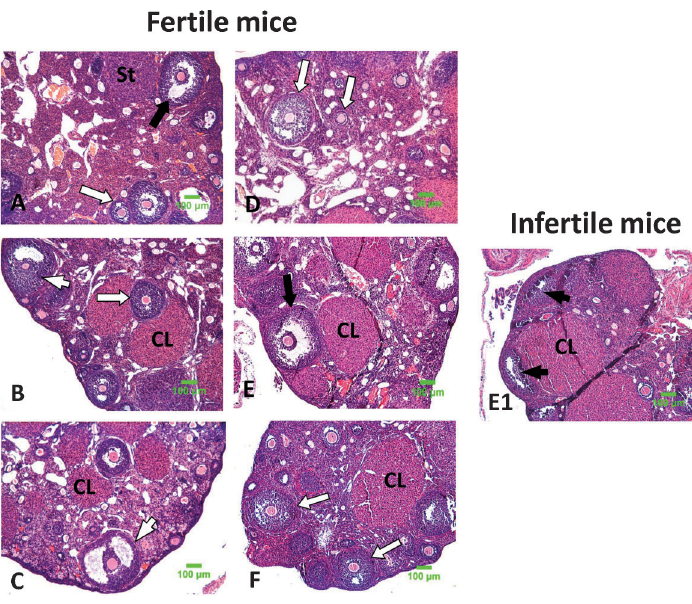
through ovarian follicles and bind to ZP to block sperm- oocyte binding in vivo (11). In several studies, high titers of ZP-specific total IgG Abs are associated with infertility in mice immunized with the recombinant ZP3 protein or ZP3 peptides (12,18,39). Consistent with those studies, we also demonstrated that the higher level of total IgG Abs was correlated with infertility in mice in the group co-immunized with chi-(pcD- Lzp3 +pcD- mIL-33 ) (Figure 5). Furthermore, chi-(pcD- Lzp3 +pcD- mIL-33 ) co-immunization also induced high levels of mucosal sIgA, which may be also correlated with decreased fertility. The mean litter size and birth rate of mice co-immunized with chi-(pcD -Lzp3 +pcD- mIL-33 ) were significantly reduced compared with control groups. opment of ovaries. Calongos et al. (40) and Lloyd et al.